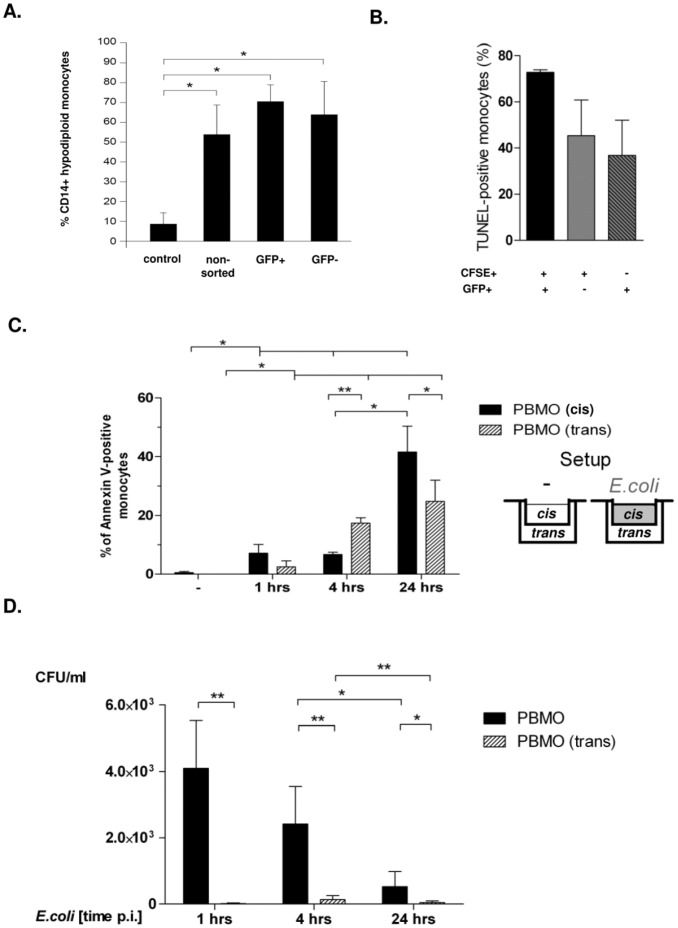
Bystander apoptosis occurs without cellular contact to the phagocyting monocyte.Monocytes were infected with E. coli-GFP and GFP –positive and -negative cells were separated by FACS sorting. Apoptosis was assessed 24 hours p.i. by quantification of hypodiploid DNA (Fig. 3A; n = 3, *p<0.05). Monocytes were infected with E.coli-GFP for one hour and free bacteria were removed. CFSE labelled monocytes of the same donor were co-incubated for 4 hours in a concentration of 10∶1. Un-infected, unlabelled monocytes served as controls. Apoptosis was assessed 4 hours p.i. in GFP+ and CFSE+ monocytes (B; n = 5). Monocytes were infected with E. coli-GFP as described (i.e. 1 hour w/o antibiotics and 3–21 hours with gentamycin) in a transwell setup for the time intervals indicated (“cis” chamber, C, sketch to the right); non-infected cells served as controls. Monocytes from the same donor were co-cultivated in compartments, separated by teflon membranes (“trans” chamber). Apoptosis was detected by assessment of hypodiploid DNA-content (C, n = 5; * p<0.05, ** = p<0.001). In the same experimental setup, a CFU-assay was performed by lysis of cells (Fig. 3D, n = 5; * p<0.05, ** p<0.001).